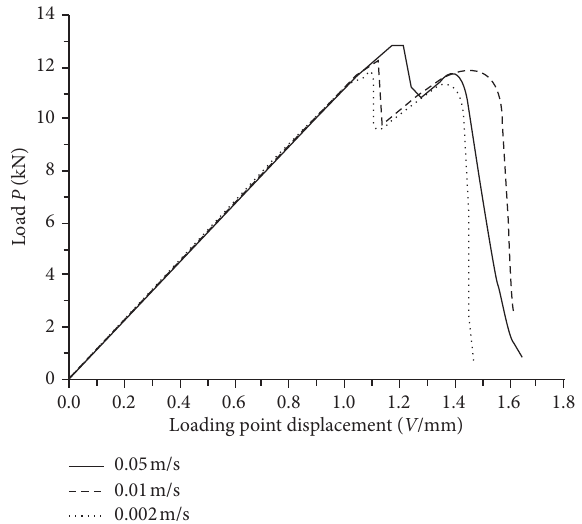
Figure 11: P - v curve of the CCNBD test under different loading